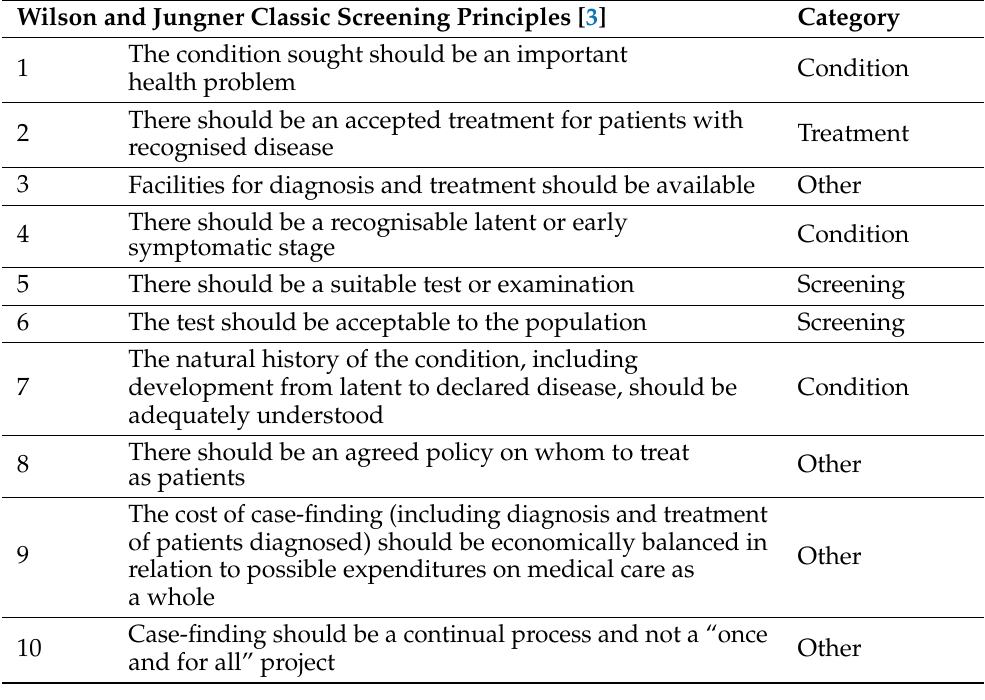
Table 1. Wilson and Jungner classic screening principles organised into four key categories. Wilson and Jungner Classic Screening Principles